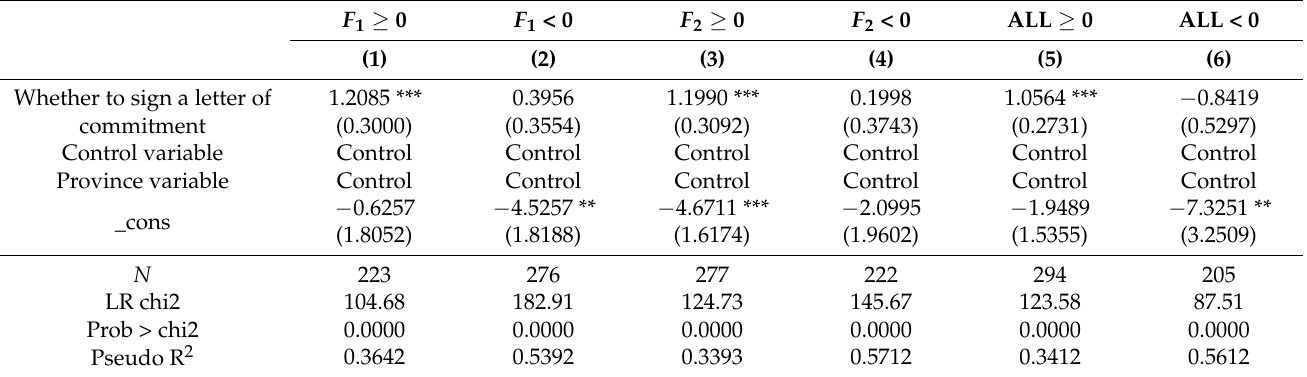
Table 6. The impact of whether commitments are made under the influence of different reward and punishment mechanisms on the recycling of sick and dead pig